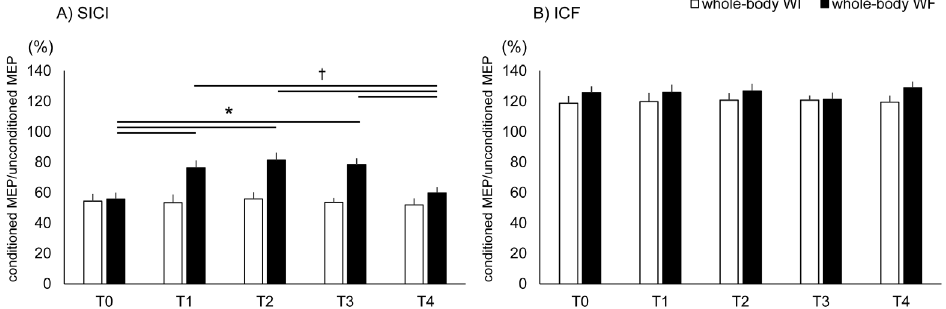
Figure 7. Changes in short-interval intracortical inhibition (SICI) and intracortical facilitation (ICF) for each intervention. The values for short interval intracortical inhibition and intracortical facilitation were normalized for each subject to their corresponding values in single-pulse stimulation. White and black bars show whole-body WI and WF, respectively. Asterisks (*) indicate significant differences (p , 0.05) compared with T0. Daggers ( { ) indicate significant differences (p , 0.05) compared with T4.